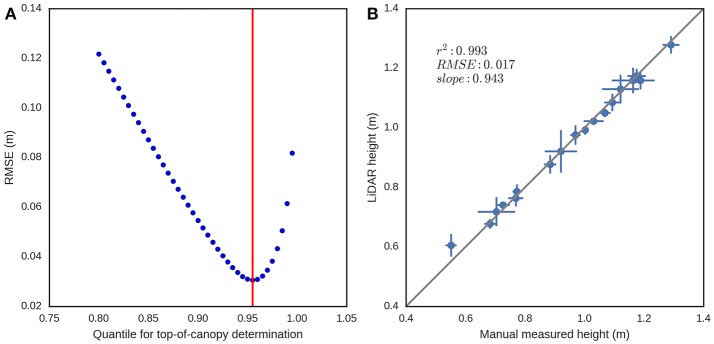
Canopy height validation from EXP1 on the 23rd Oct. 2014. (A) RMSE between canopy height measured manually with three replicate measures of canopy height per experimental plot and LiDAR canopy height derived from different quantile values, ranging from 0.8 to 1.0 at increments of 0.005, in the z coordinate. (B) Scatter plot of canopy height measured manually and LiDAR canopy height for the optimum quantile of 0.955. Error bars are plus-minus the standard deviation of the measurements for each genotype (three replicate experimental plots per genotype and 18 genotypes).